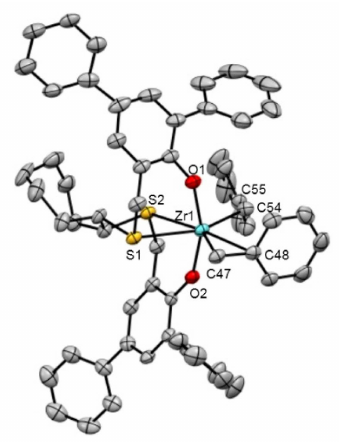
Figure 1. ORTEP drawing of dibenzyl zirconium(IV) complex 9 (50% thermal ellipsoids, hydrogen atoms and solvated toluene molecules were omitted for clarity). Selected bond lengths Å and bond angles ˝ : Zr1–O1 = 1.998 (2), Zr1–O2 = 2.005 (2), Zr1–C47 = 2.305 (3), Zr1–C48 =